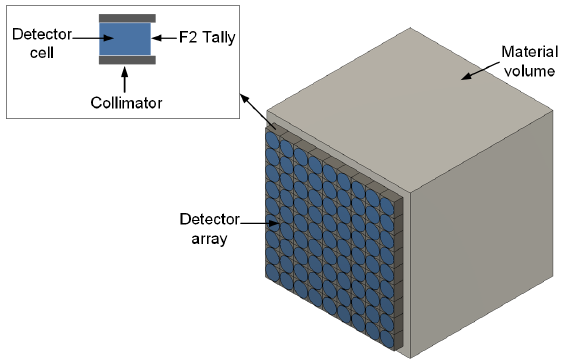
Figure 2. Sketch of the MCNPX simulation model.